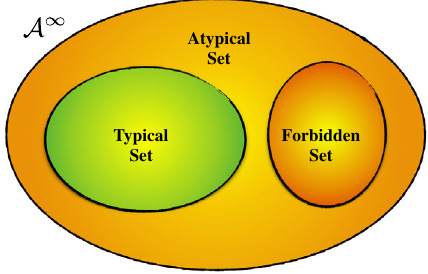
FIG. 3. For a given process, the space A ∞ of all sequences is partitioned into forbidden sequences, sequences in the typical set, and sequences neither forbidden nor typical — the atypical or rare